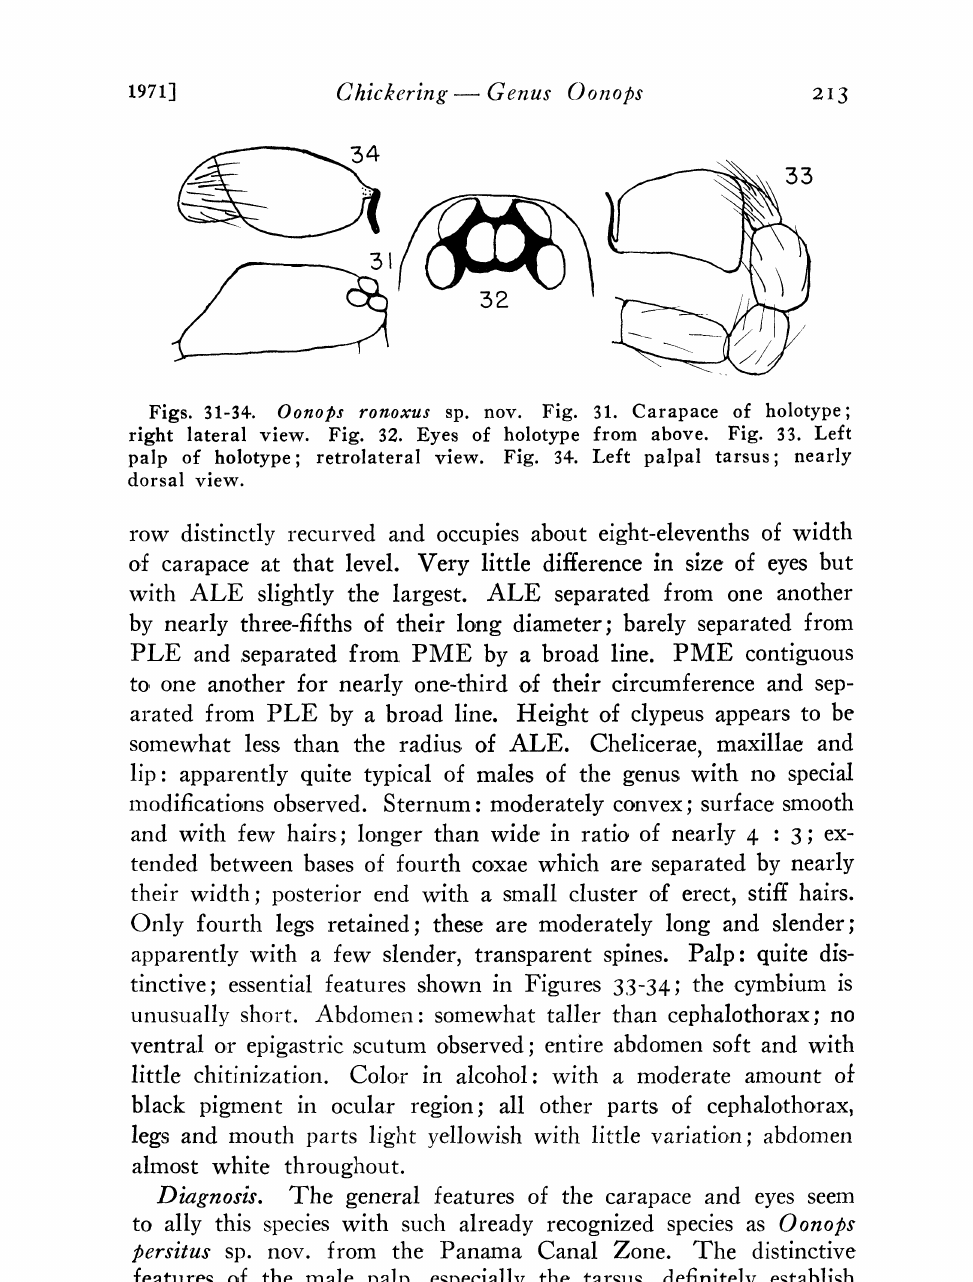
Figs. 31-34. Oonols ron, oxus sp. nov. Fig. 31. Carapace of holotype; right lateral view. Fig. 32. Eyes of holotype from above. Fig. 33. Left palp of holotype; retrolateral view. Fig. 34. Left palpal tarsus; nearly dorsal